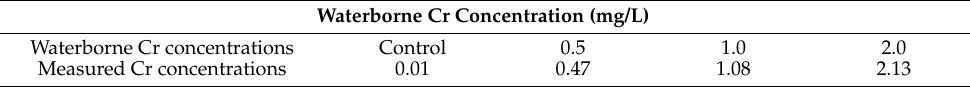
Table 2. Comparison of target concentration and the actual concentration of each